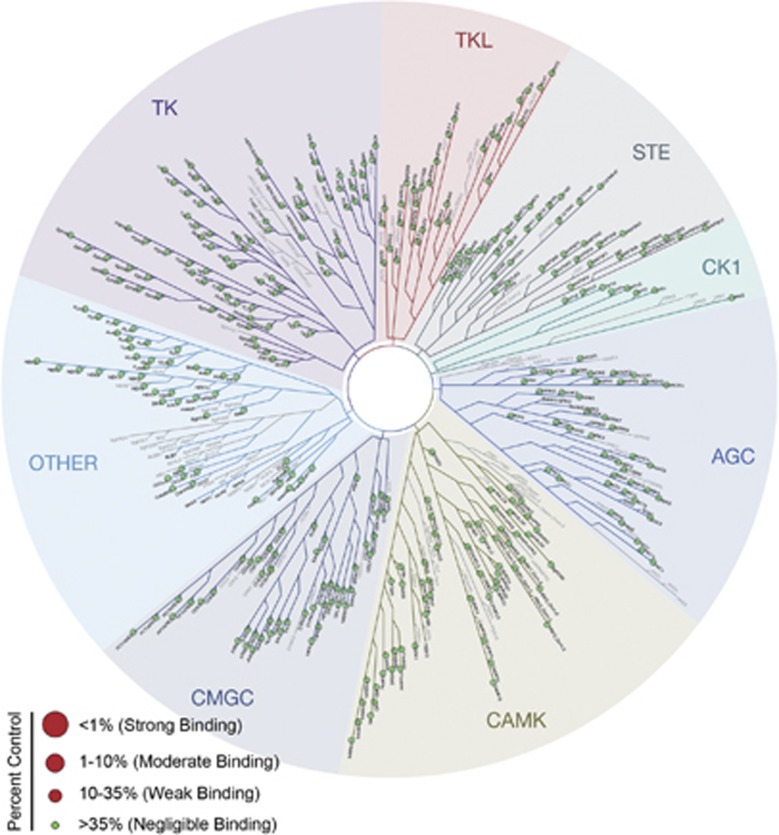
The ability of TBPT to bind and inhibit 442 kinases in the human kinome. TBPT was screened twice at 5 and 10 μM using a kinome scanning assay. The 35% of the binding percentage of DMSO was used as the criterion of negligible binding, as suggested by the manufacturer and previous reports.60, 61, 62 If any kinase binds TBPT (%Ctrl<35%), then a large red dot is shown in the kinome tree. The binding and inhibitory percentages for TBPT for all 442 human kinases (covering 80% of the human kinome) were greater than the criterion (35%). The kinase groups are abbreviated as follows: TK, tyrosine kinase; TKL, tyrosine kinase-like; STE, homologs of the yeast sterile 7, 11 and 20 kinases; CK1, casein kinase 1; AGC, the protein kinase A-, G- and C-containing families; CAMK, calcium/calmodulin-dependent protein kinase; CMGC, cyclin-dependent kinase-, mitogen-activated protein kinase-, glycogen synthase kinase 3-, and dual-specificity protein kinase-containing families; OTHER, all other protein kinases that do not belong to specific groups. The detailed results are presented in Supplementary Table S3